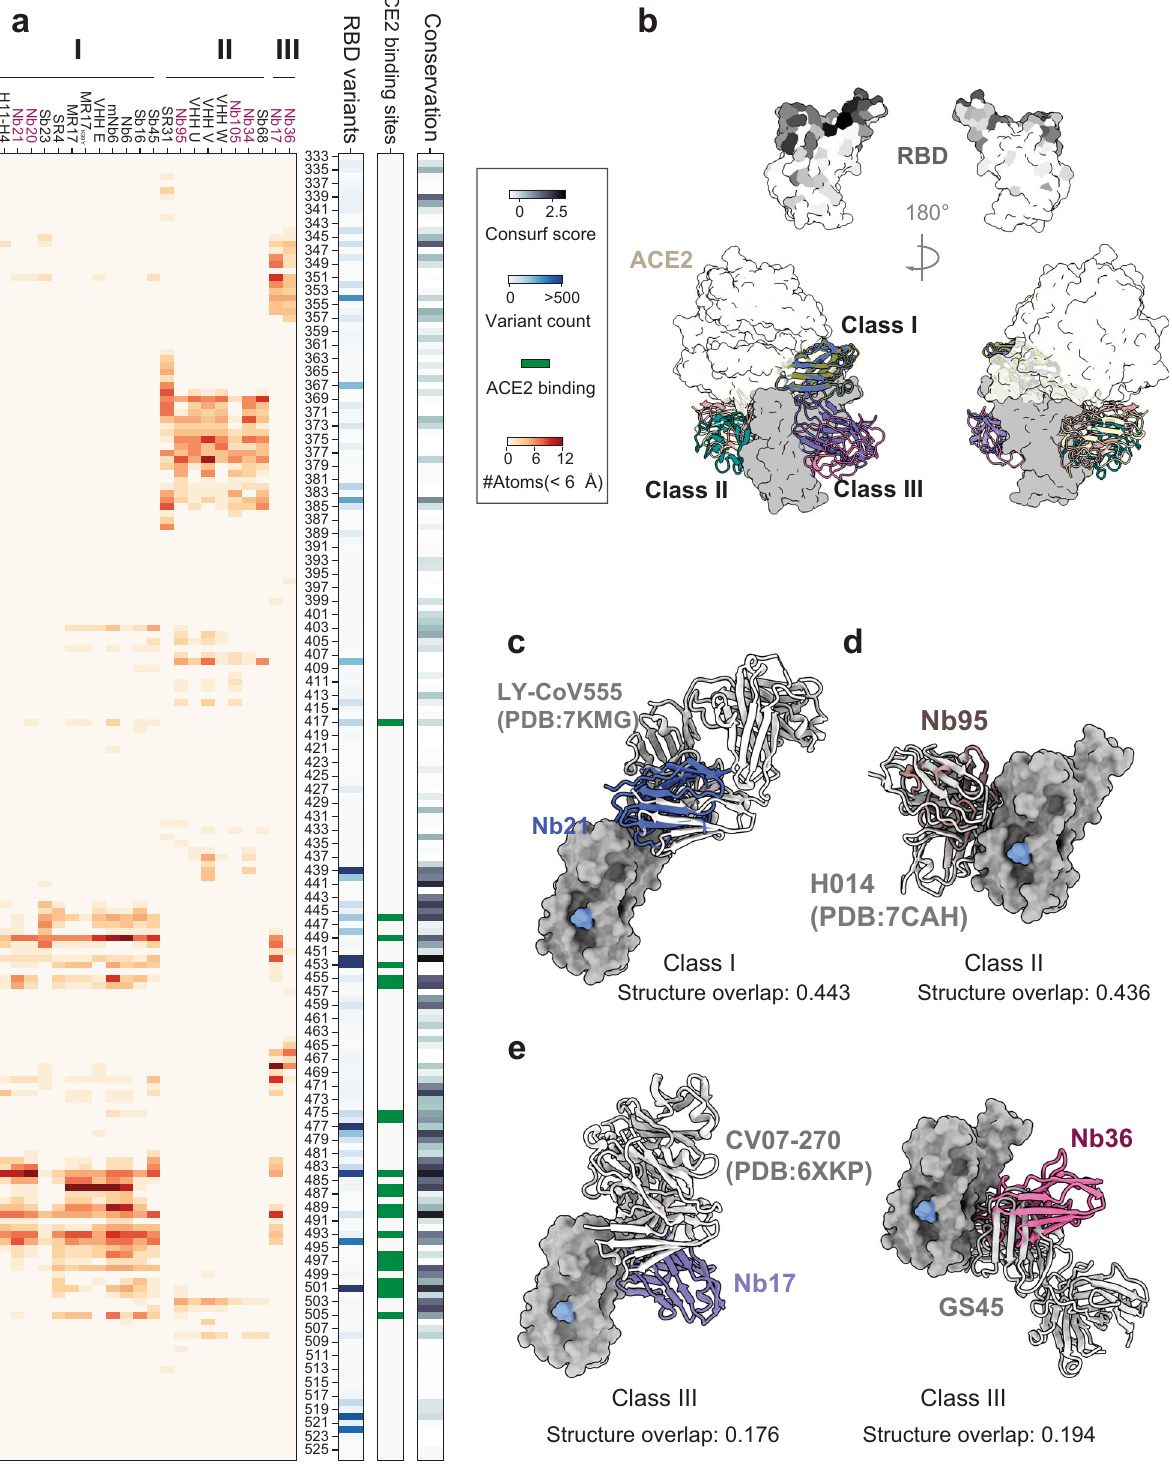
Fig. 5 Class III Nbs bind semi-conserved epitopes unique to Nbs. a Epitope clustering analysis of RBD Nbs and correlation with RBD sequence conservation and ACE2 binding sites. The conservation scores of SARS-CoV-2 Spike RBD amino acids were computed by ConSurf server using the empirical Bayesian method from the multiple sequence alignment and normalized by the z -score method. b Overview of three Nb classes binding to the RBD, RBD surface was colored based on conservation (ConSurf score). c – e . Structural comparison of different classes of Nbs with the closest mAbs for RBD